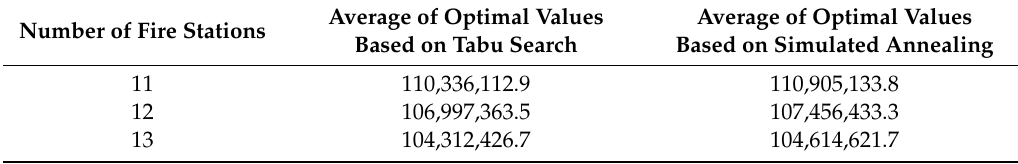
Table 4. Average of optimal values for 10 iterations of the model using both algorithms.